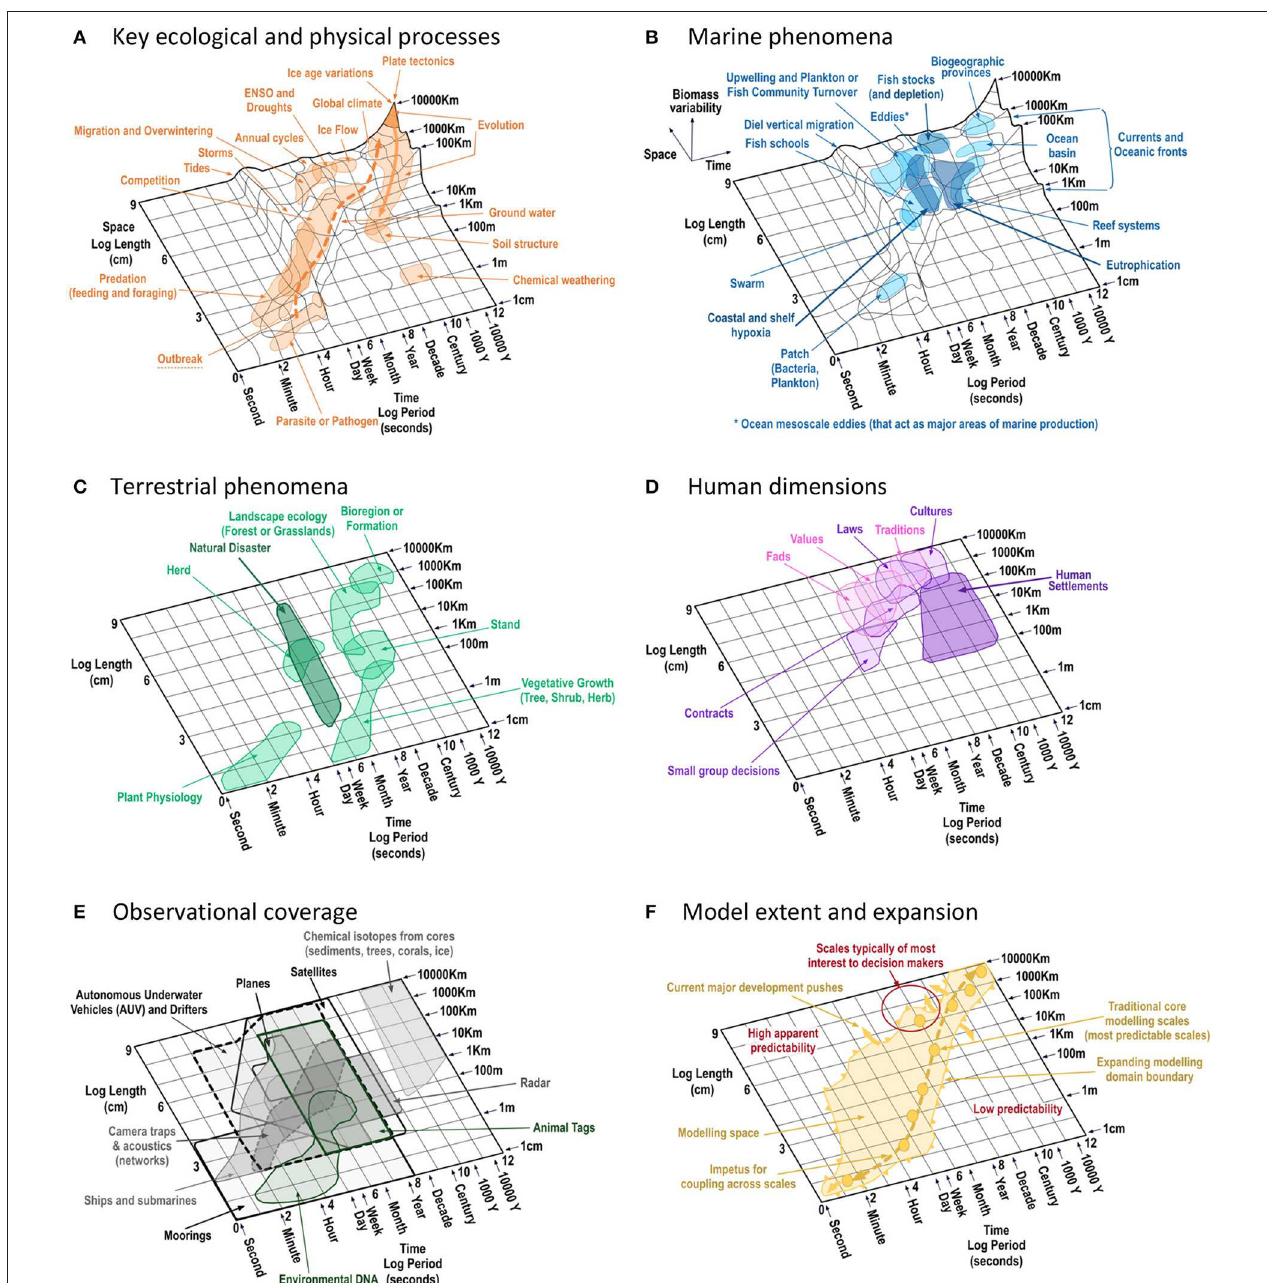
FIGURE 1 | Set of schematic Stommel diagrams showing: (A) key ecological processes (with the solid arrow indicating the new understanding about the scales of action of evolution and the dashed line showing the cross scale connection ecology is realizing stems from linking processes at different scales such as parasitism, ecosystem structure and function and large scale nutrient cycles); (B) marine phenomena (components and processes); (C) terrestrial phenomena (including the scale of natural disasters such as fire, flood, earthquakes, and volcanoes); (D) human dimensions (including the scale of human settlements and decision making processes and influences); (E) observational scales from illustrative major sensor platform types (noting that citizen science is significantly extending data collection beyond the scales of the platforms shown); and (F) the scales most reliably captured by models (the solid dots indicate scales well-captured by traditional approaches, the shaded area the growing extent of models, the small and large arrows the push for continuing development and the dashed line the push for coupling across scales; there may be additional model types that already sit outside the shaded domain, but it is largely indicative of the scope of scales covered). Together these diagrams create a conceptual figure highlighting the scales and disciplinary dimensions that characterize reality. The base figure for the key ecological process and marine components is redrawn and updated from Vance and Doel (2010). For the other diagrams the scales of the key phenomena and system features also drawn from Clark (1985b), Marquet et al. (1993), Peterson et al. (1998), Westley et al. (2002), Scholes et al. (2013), Kavanaugh et al. (2016), and Rose et al. (2017). Note for these other diagrams (C–F) , we have chosen to draw them on a flat two dimensional space as the original Stommel diagram’s third dimension may not be as relevant for these other dimensions (but there was insufficient information to reliably try to replicate this third axis for the other properties).